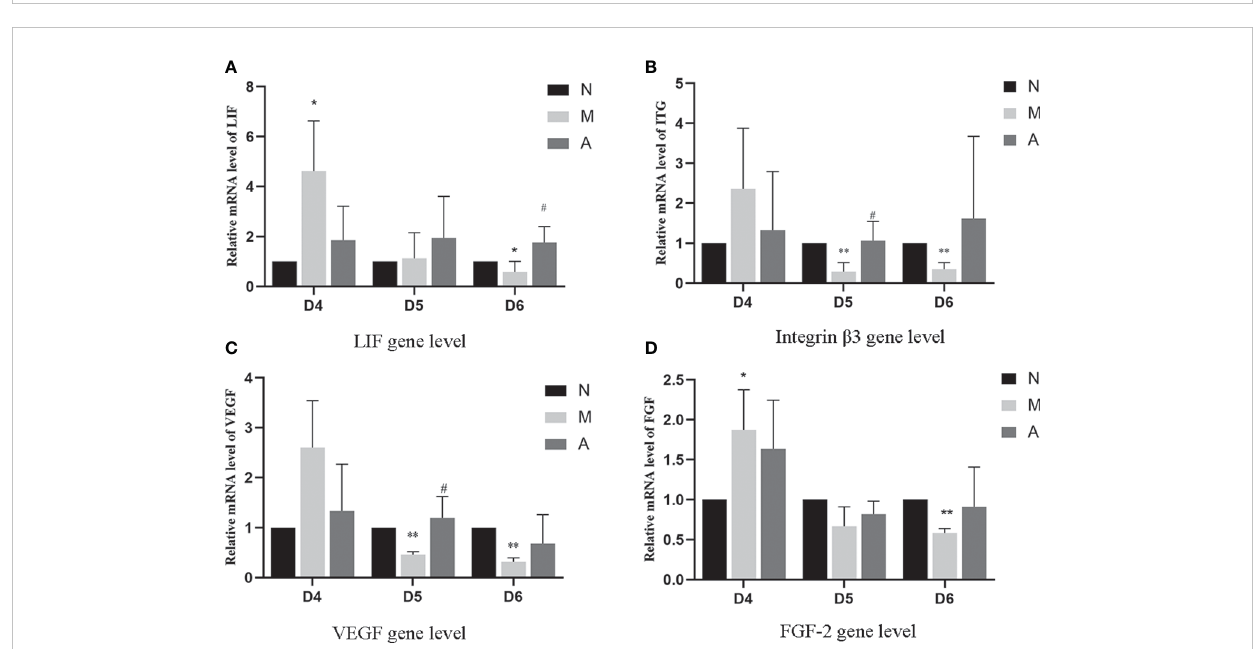
FIGURE 8 The expression of LIF (A) , integrin b 3 protein (B) , VEGF (C) , and FGF-2 (D) mRNA levels in the endometrium (n=5). *or** represents that there is signi fi cant difference between M and N groups ( P < 0.05 or P < 0.01), #or ## represents that there is signi fi cant difference between A and M groups ( P < 0.05 or P < 0.01). LIF, Leukemia inhibitory factor; VEGF, Vascular endothelial growth factor; FGF-2, Fibroblast growth factor 2; mRNA, Messenger RNA; D, The embryo day; N, Normal group; M, Model group; A, Acupuncture